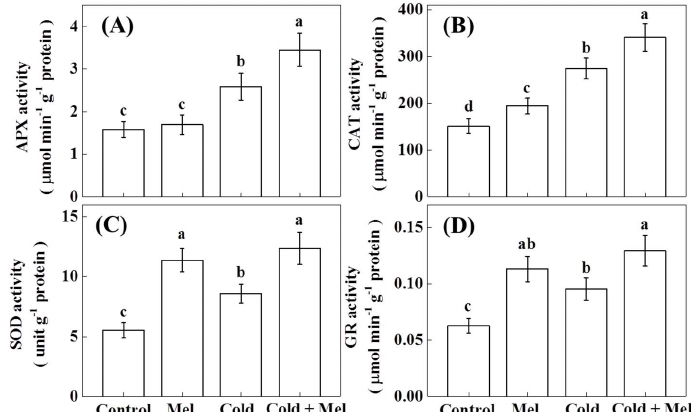
Figure 4. Effect of melatonin application on ( A ) ascorbate peroxide (APX), ( B ) superoxide dismutase (SOD), ( C ) catalase (CAT), and ( D ) glutathione reductase (GR) activities in tea leaves in the presence or absence of cold stress treatment. Mel, melatonin. Each data point presents the mean of six replicates (± S.D.(standard deviation)). Means denoted by different letters are significantly different ( p < 0.05) based on the Tukey’s test.